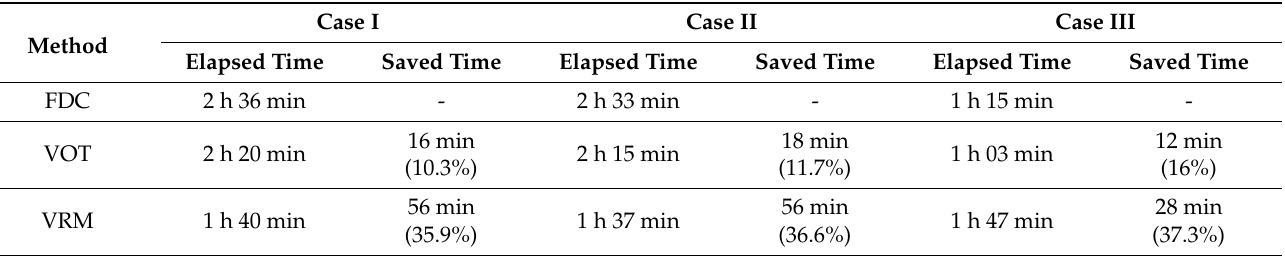
Figure 9. Measured curves of three cases with three control methods: ( a ) case I; ( b ) case II; and ( c ) case III. Table 6. Summary table of three cases.